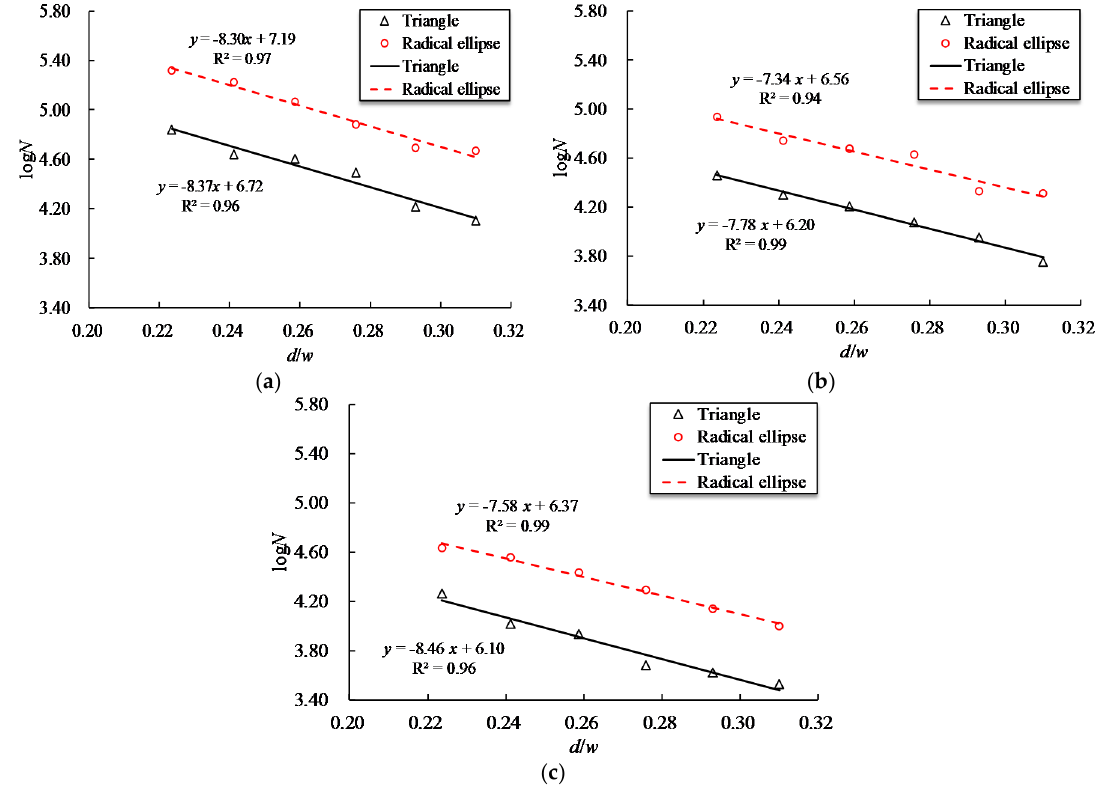
Figure 9. Relationship between fatigue life and d / w of triangular and radial elliptical notches at three stress levels. ( a ) 0.4 R m ; ( b ) 0.5 R m ; ( c ) 0.6 R m . stress levels. ( a ) 0.4 R m ; ( b ) 0.5 R m ; ( c ) 0.6 R m